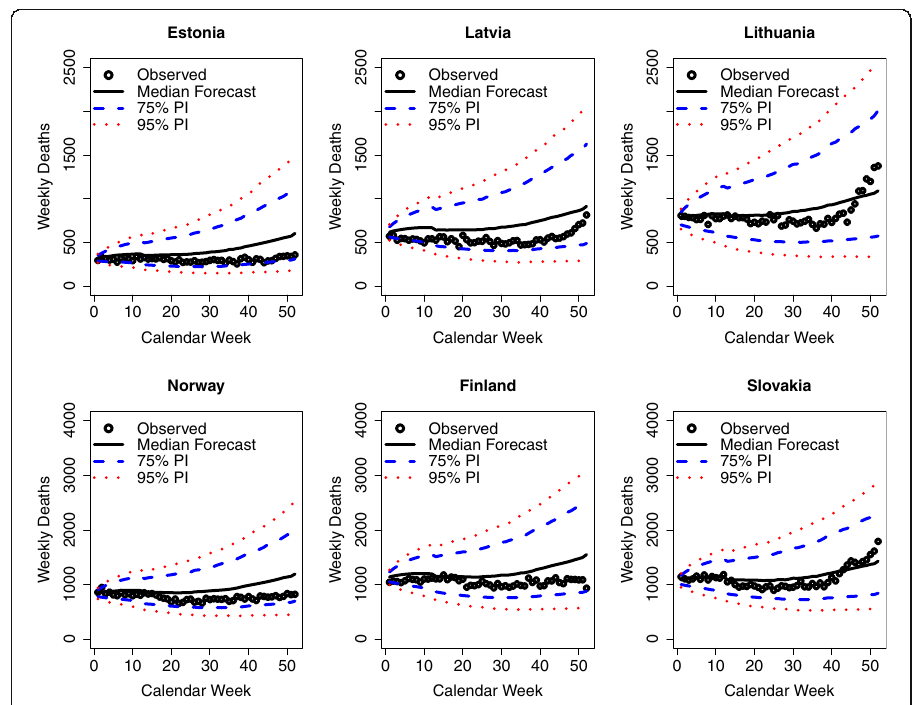
Fig. 8 Observed and predicted weekly deaths in 2020 by country for the Northern European Countries without statistically significant excess mortalities. Sources: Human Mortality Database (2021); Computations and design by the